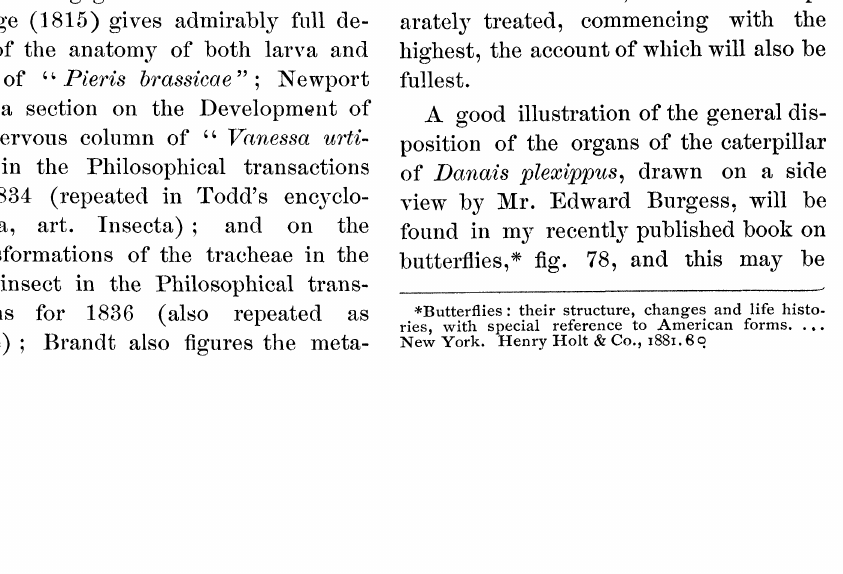
same insect in the Philosophical trans-